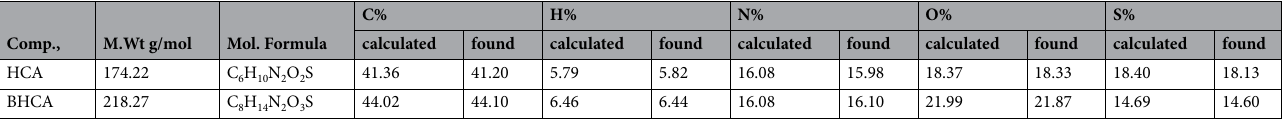
Table 2. Elemental analysis of the synthesized HCA and